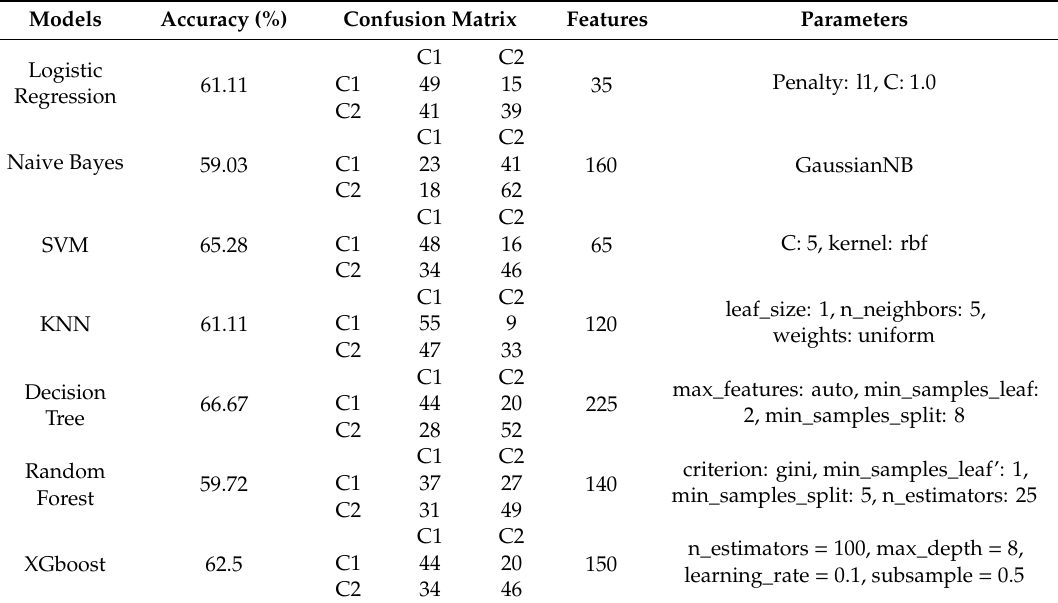
Figure 9. Learning curves with testing accuracy scores on dataset C for different ML models trained on feature subsets of increasing dimensionality. Table 6. Best testing accuracies achieved for each ML model along with the confusion matrix, the optimum number of features and the hyperparameters of the ML models employed. C1 and C2 denote classes 1 and 2 of dataset C,